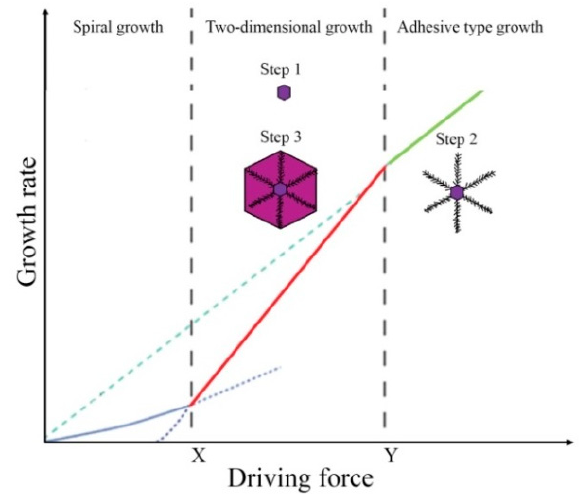
Figure 14. Schematic diagram showing growth rate versus driving force of the three development stages of trapiche ruby. The diagram shows the different types of crystal growth mechanisms, modified from [47]: spiral growth, two-dimensional growth, and adhesive-type growth. The increasing intensity of the driving force is presented between the critical points X and Y, where nucleation occurred. The curves represent growth rate versus driving force relations for the three mechanisms. The curve (in blue) shows the spiral growth mechanism; the curve (in red) represents the two-dimensional nucleation growth mechanism; the curve (in green) denotes the adhesive-type mechanism. A rough interface is expected above point Y and it corresponds to the dendritic stage of trapiche-ruby formation. The nucleation occurred between X and Y domains where the growth sectors formed in trapiche texture. Finally, a smooth interface is expected below X where nucleation by dislocation occurred either for non-trapiche ruby or in overgrowth zone in trapiche ruby.